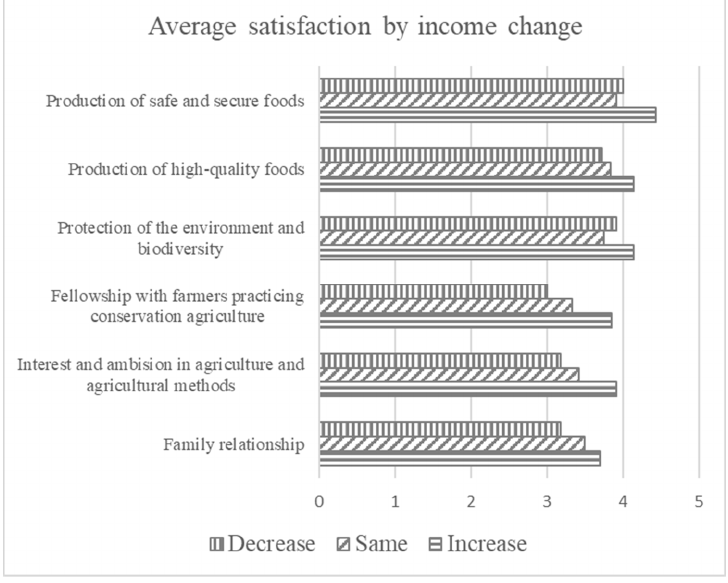
Figure 4. Average satisfaction of farmers practicing conservation agriculture by income change.